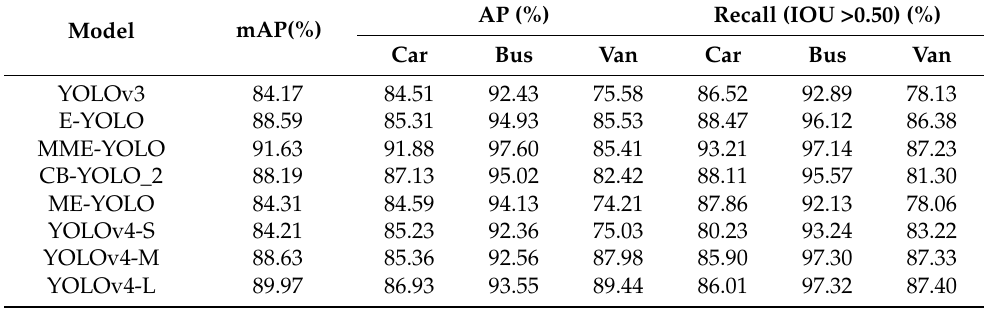
Table 3. Comparison of models on the private Road-side Dataset. We intensively compare the proposed model with the baselines in different categories for AP and Recall. The multi-sensor multi-level composite module improves the performance of visual detectors impressively.